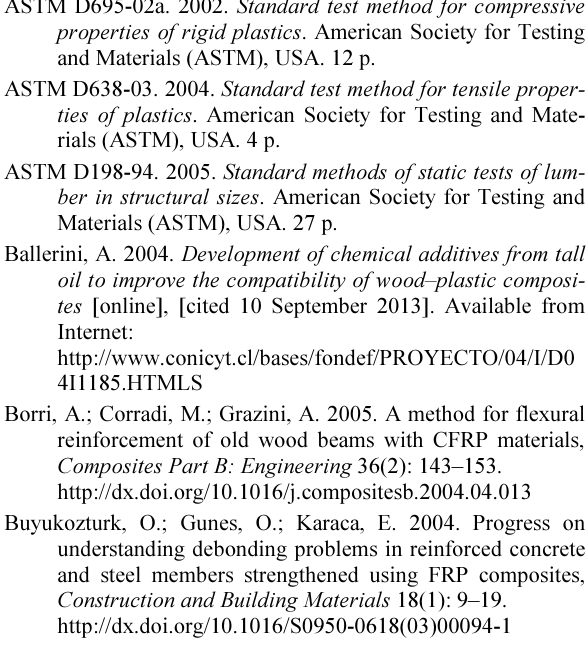
Fig. 23. Average ultimate failure loads of different groups of specimens with two layers of